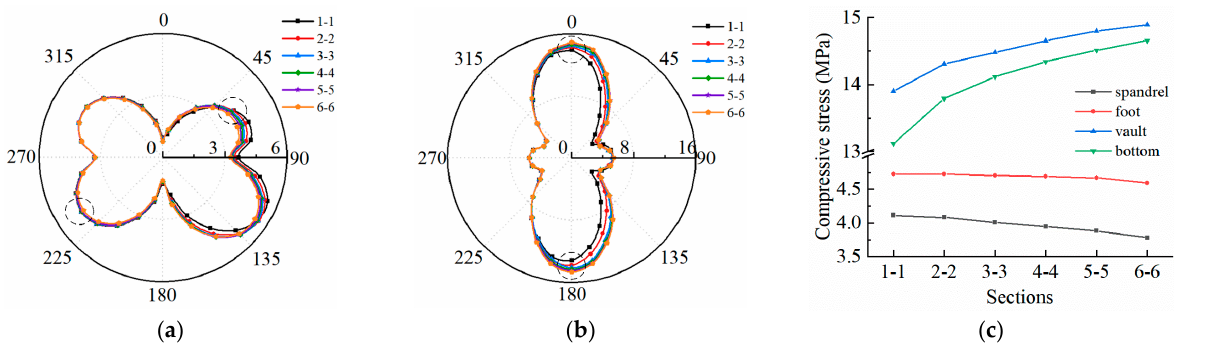
Figure 10. Compressive stress at each section (MPa): ( a ) stress envelopes at incident angle of 0°, ( b ) stress envelopes at incident angle of 30°, and ( c ) curves of max compressive stress values. Figure 9 shows the tensile stress envelopes and max value curves of each